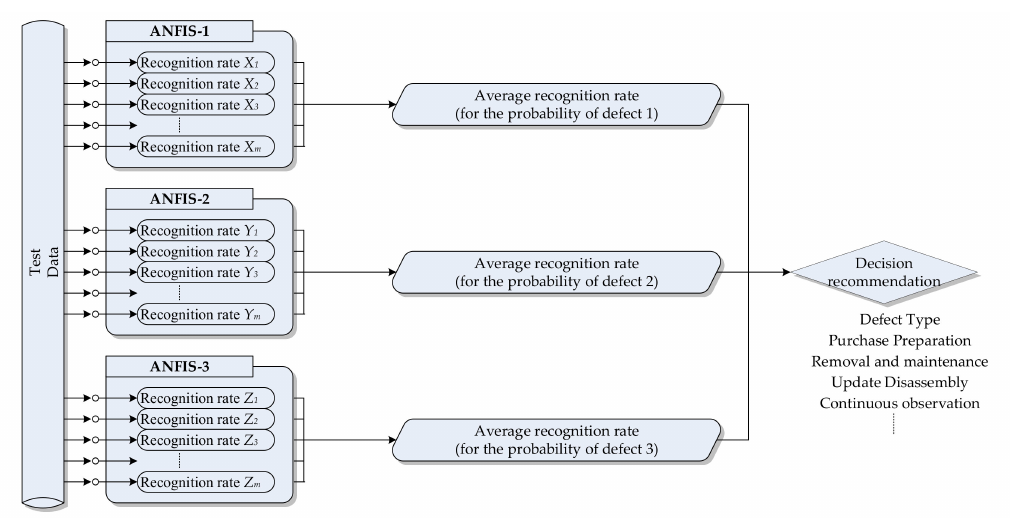
Figure 6. Schematic diagram of the parallel recognition